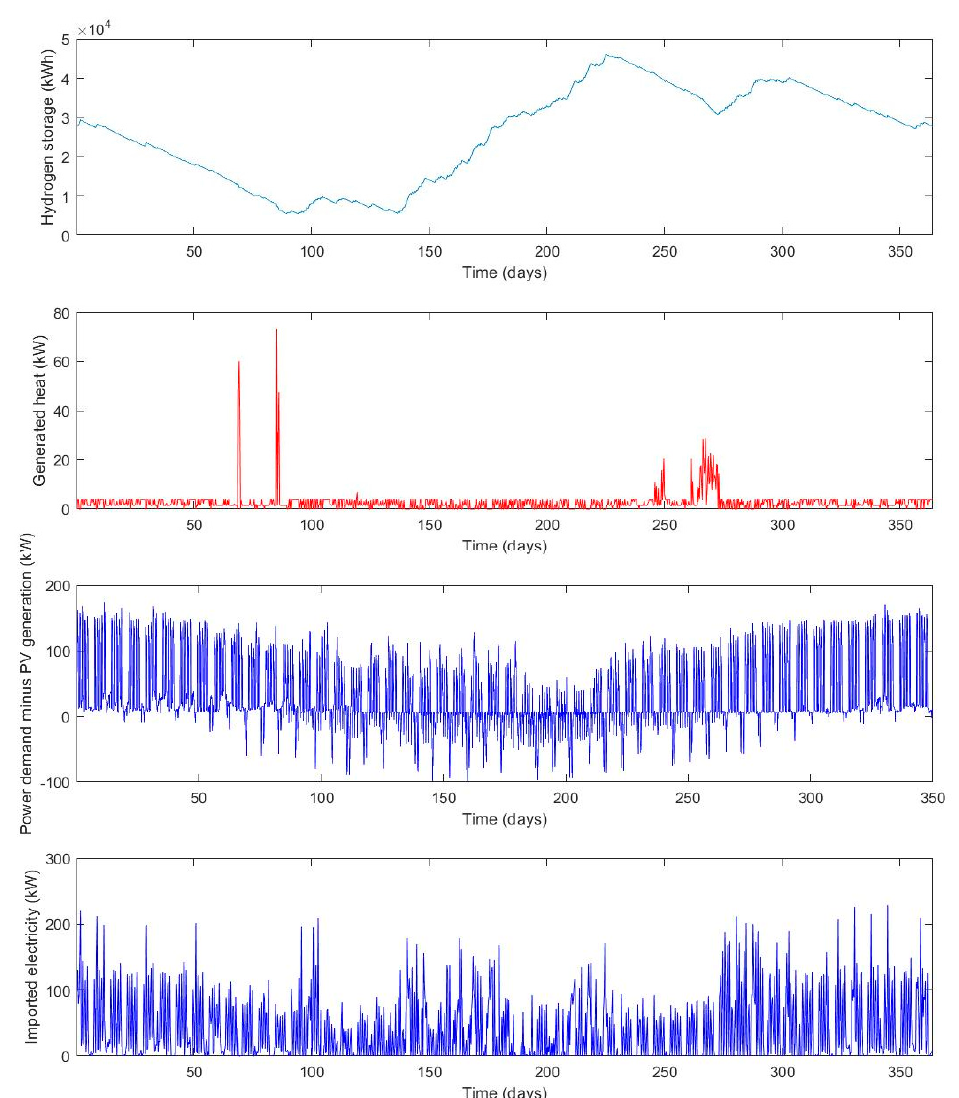
Figure A1. Optimal operation of a 20/80 kW RSOC system with 1000 m 2 solar PV panel.